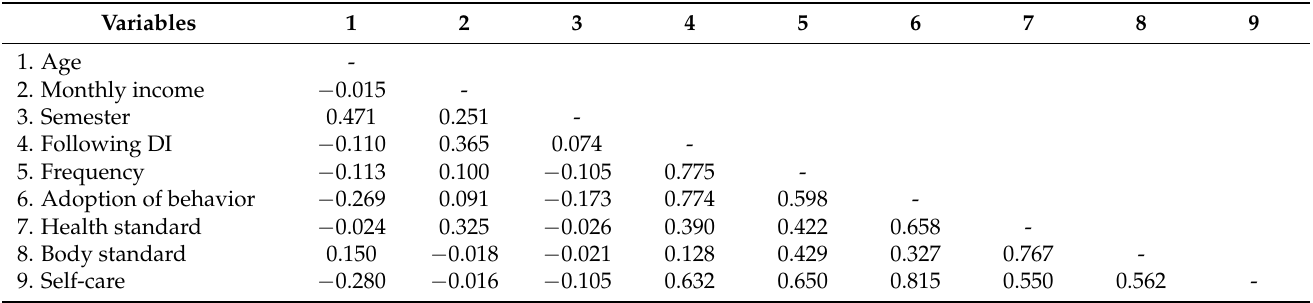
Table 5. Weight matrix for the associations between the network variables for